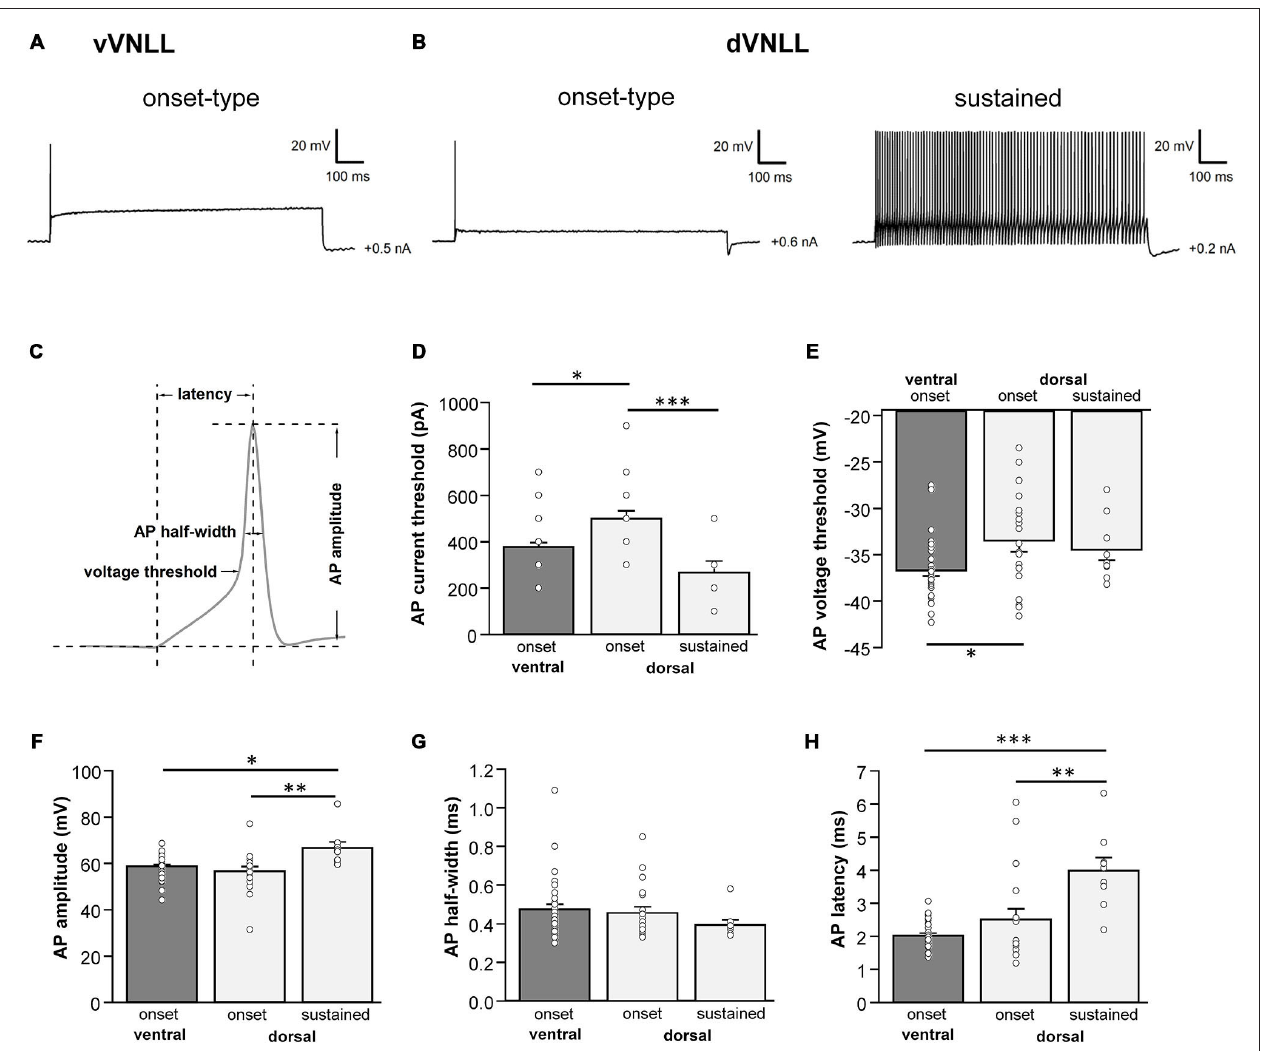
FIGURE 2 | Heterogeneous firing properties differ between neurons of the dVNLL and vVNLL. (A) Representative voltage traces recorded from a vVNLL neuron (A) and from dVNLL neurons (B) during a depolarizing current injection. (C) Schematic diagram illustrating the analysis of the active membrane properties. The first action potential (AP) elicited by the lowest current injection was used for analysis. (D) Current threshold eliciting the first action potential for vVNLL and dVNLL neurons. (E) Voltage threshold, (F) AP amplitude, (G) AP half-width and (H) AP latency of the first elicited AP for vVNLL and dVNLL neurons. dVNLL: onset-type n = 19, sustained n = 9, vVNLL onset-type n = 34. Statistical significance was determined by a single-factor ANOVA test followed by a Scheffé’s post hoc test; ∗ p < 0.05; ∗∗ p < 0.01; ∗∗∗ p <